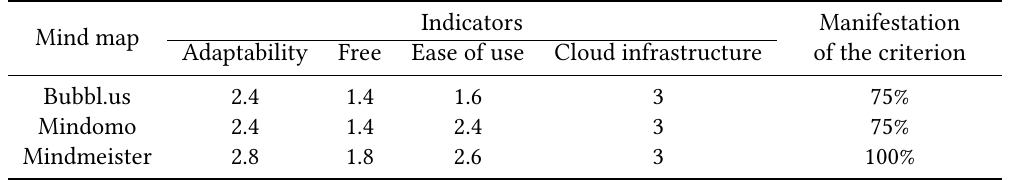
Indicators Manifestation